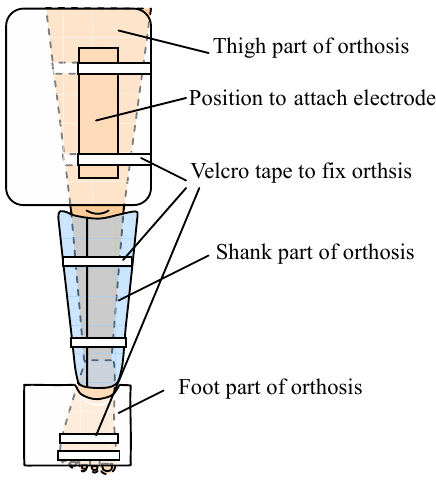
Fig. 10 Overview of attached orthosis